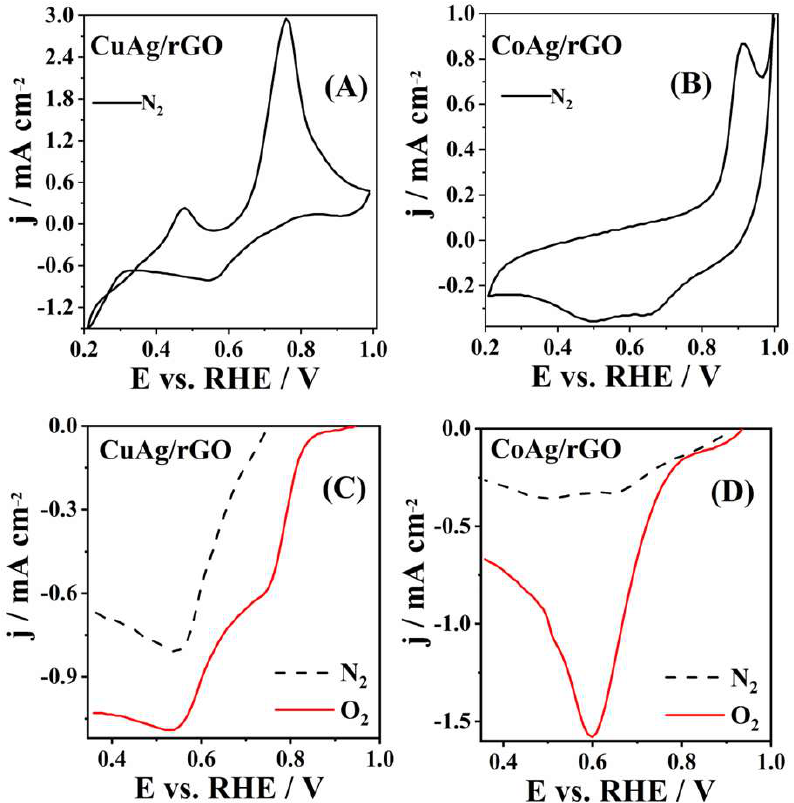
Figure 5. CVs of CuAg/rGO ( A ) and CoAg/rGO ( B ) electrocatalysts recorded at 20 mV s − 1 in N 2 -saturated 0.1 M KOH solution and the cathodic part of CVs of CuAg/rGO ( C ) and CoAg/rGO ( D ) electrocatalysts recorded at 20 mV s − 1 in N 2 - and O 2 -saturated 0.1 M KOH solution. ORR polarization curves of CuAg/rGO and CoAg/rGO electrocatalysts obtained at 1600 rpm in O 2 -saturated solution are presented in Figure 6A. E onset and E 1/2 were found to be 0.81 and 0.71 V for CuAg/rGO and 0.76 and 0.62 V for CoAg/rGO, respectively. Thus, CuAg/rGO showed 50 and 90 mV more positive ORR E onset and E 1/2 , respectively, com- pared to the CoAg/rGO electrocatalyst. Ag@CuO nanoparticles showed E 1/2 of 0.74 V [66],